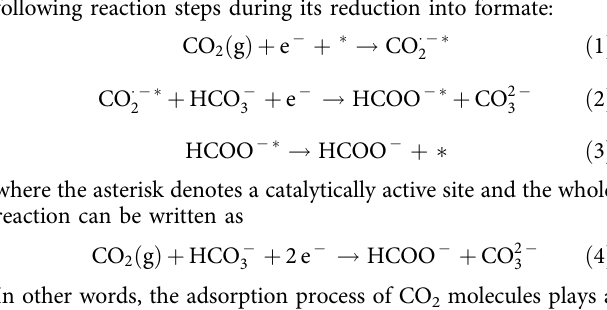
oo 1, while the 2